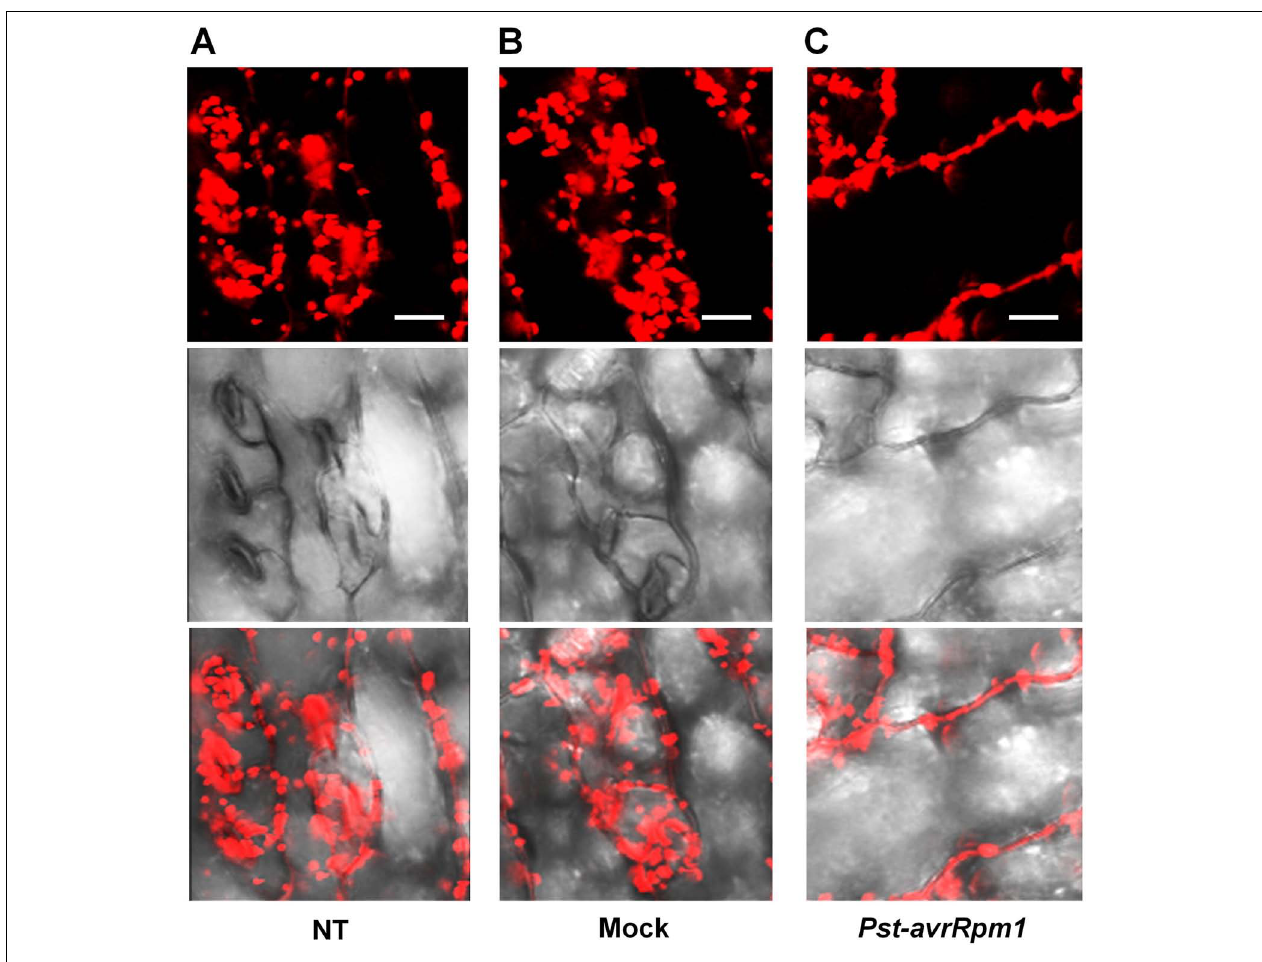
control (A) and 0.015% Silwet/10 mM MgCl 2 -treated mock (B) in close-to-mature leaves where PLA 2 α is already detected at a low level in the apoplasts. Fluorescent (top), bright field (middle), and merged images (bottom) are presented. Bars = 20 μ